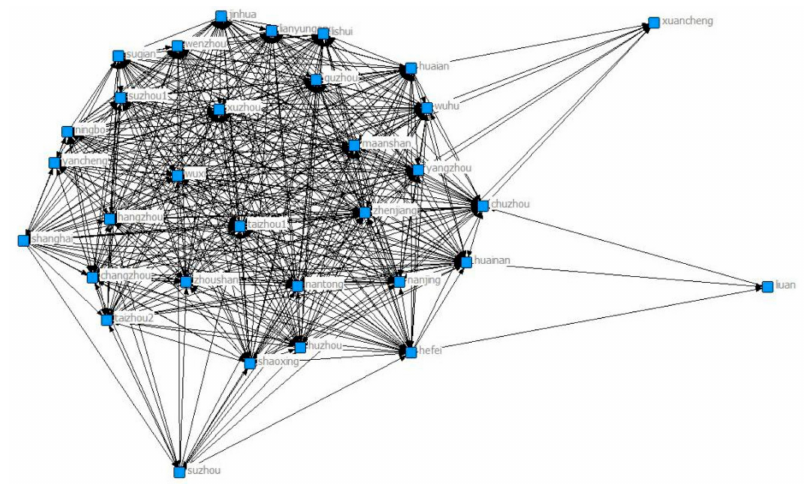
Figure 6. Yangtze River Delta collaborative network in 2014.